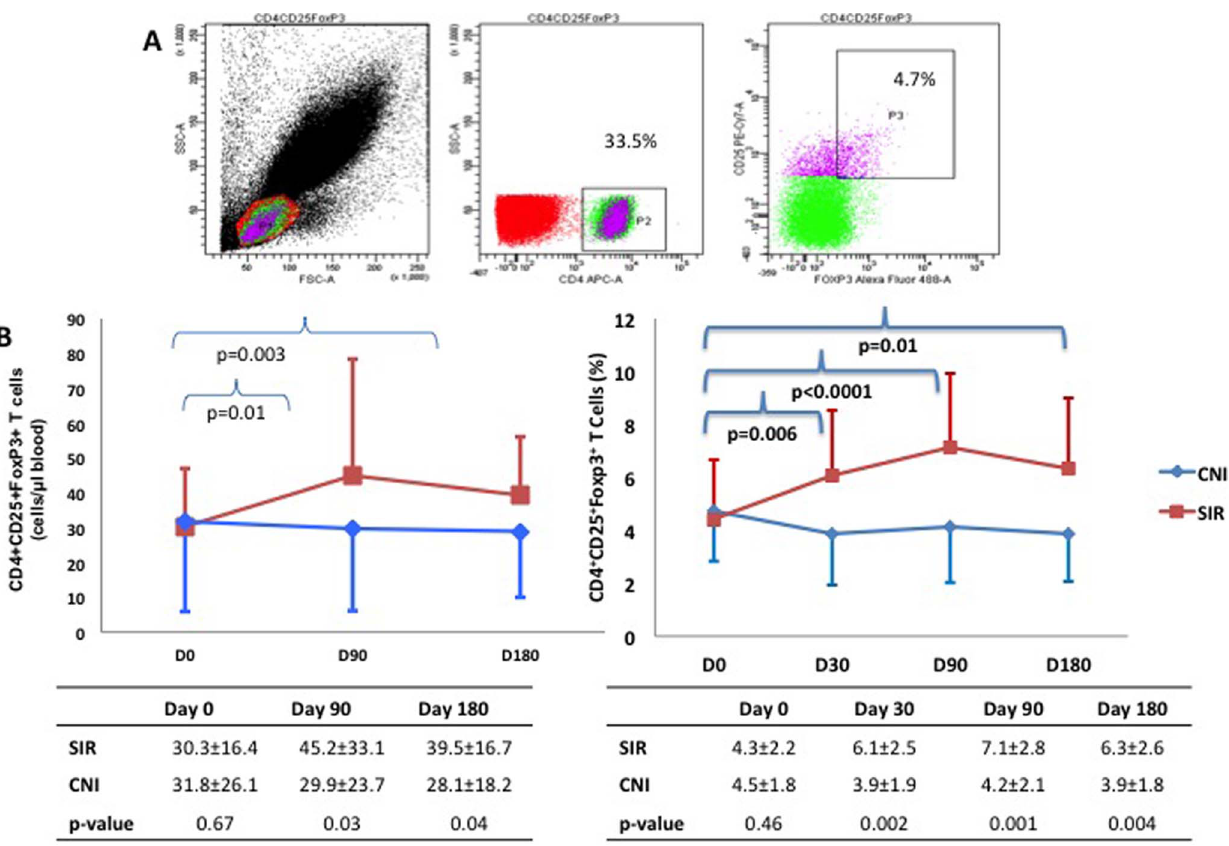
Figure 3. A. Dot plot showing analysis of (T reg ) by flowcytometry and B. Graph showing T reg number and frequency at different time points in the study in the two groups. Compared to baseline, SIR group showed higher T reg number and frequency at all time points whereas there was no change in the CNI group. Compared to CNI group, SIR group showed higher T reg number and frequency. doi:10.1371/journal.pone.0075591.g003 Thus risk profile of our patients should be seen in the context of Search is on for strategies that could affect the repertoire of less robust induction therapy as well. immune cells in a way as to tilt the balance in favor of cells that would inhibit antigen specific response. CD4 + CD25 + T regula-